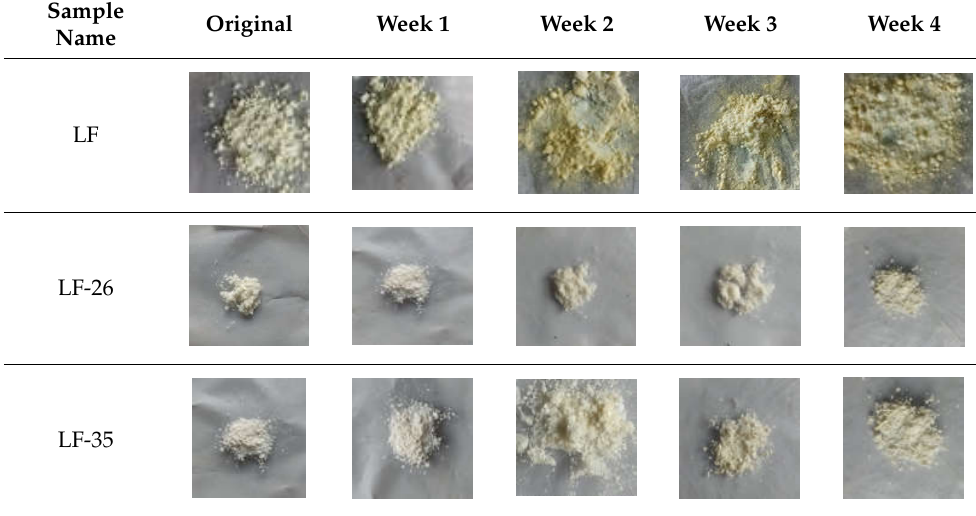
14 of 24 Figure 10. Hydrate transformation profile of LF (levofloxacin), LF-26 (levofloxacin-2,6 dihy- droxybenzoate), and LF-35 (levofloxacin-3,5 dihydroxybenzoate) for four weeks in condition 75 ± 1.0% RH/25 ± 0.5 °C. By contrast, LF-26 was steady in its anhydrous form (~0.5% water), and LF-35 was steady in its hemihydrate form (~2.2% water). This result was also attained in a study on levofloxacin–citric acid salt, in which the water molecule of LF was replaced by a citric acid molecule on the N-methylamine site [24]. The data show that the salts absorbed a lesser amount of water molecules than LF alone, probably due to the surface property change and the more compact packing of the salts compared with that of the parent compound [56]. The data for the test of stability towards lighting are shown in Table 2, depicting the